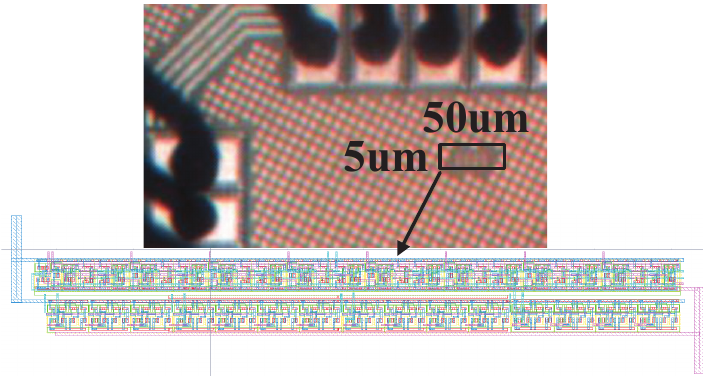
Figure 4. The microphotograph of the proposed RO PUF chip.